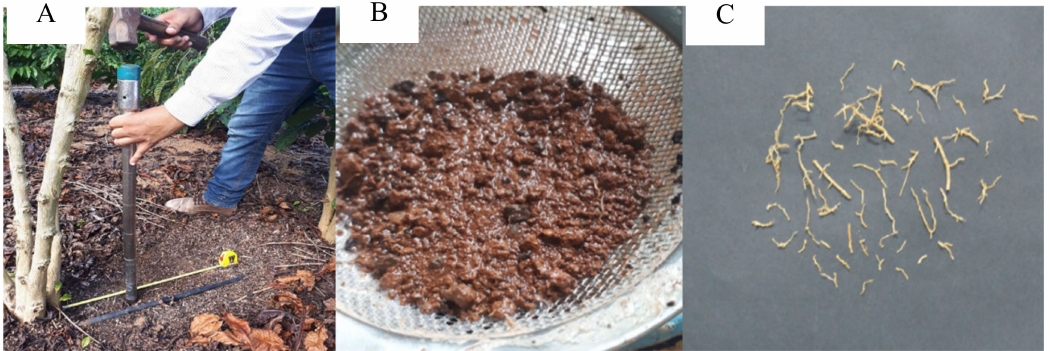
Figure 1. Approach used for sampling the roots of 43 C. canephora genotypes, including soil sampling ( A ), washing ( B ) and roots used for scanning ( C